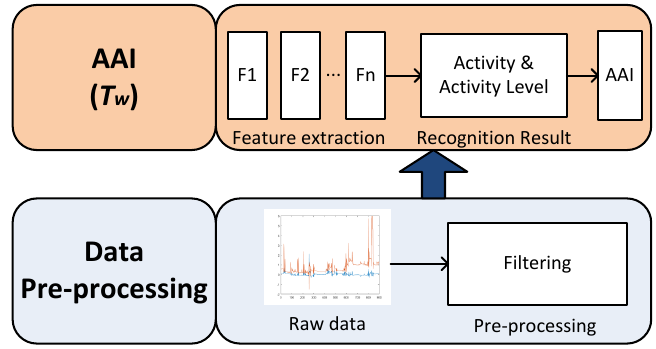
Figure 4. Activity level assessment